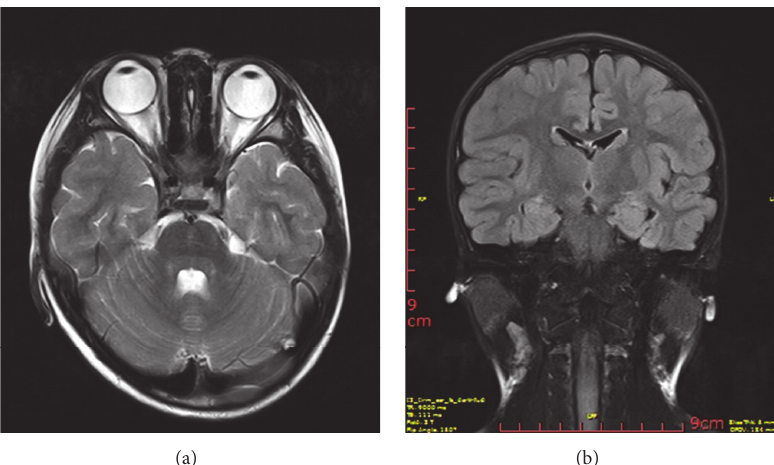
Figure 3: (a) shows the enlargement of bilateral optic nerves. (b) shows the demyelination spots of the right frontal and parietal lobes in